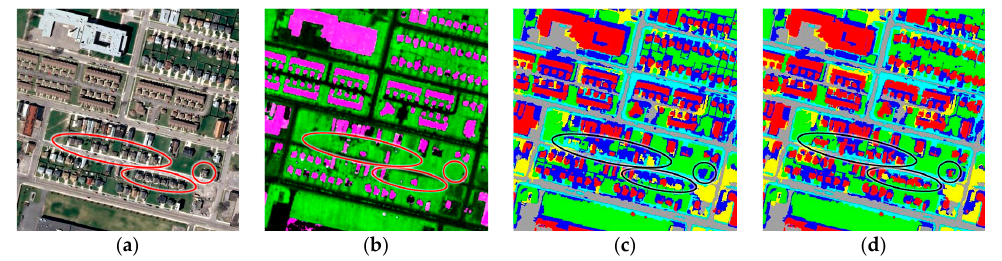
Figure 19. Fusion for changed areas between multi-temporal data: ( a ) high-resolution image, ( b ) LiDAR data, ( c ) joint classification map using LiDAR data and high-resolution image before object-based post-classification fusion, and ( d ) classification map after object-based post-classification fusion.